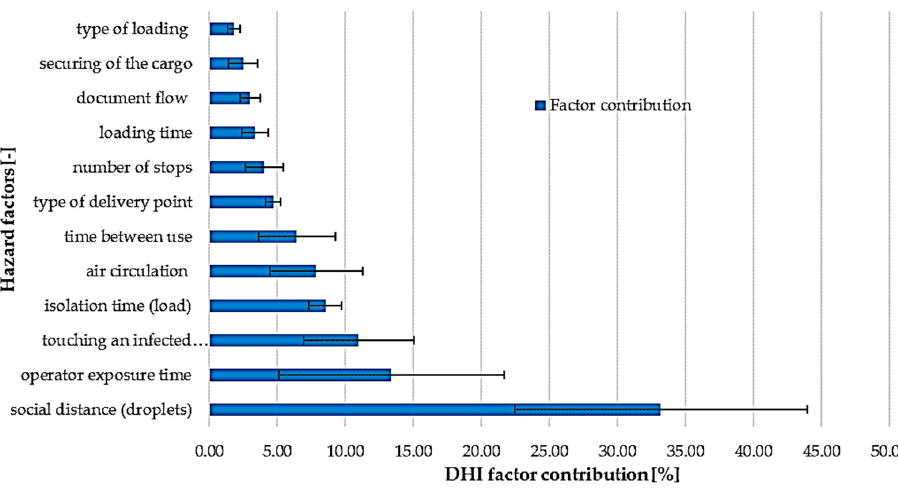
Figure 8. Sum of weighted assessments for each of the hazard factors.